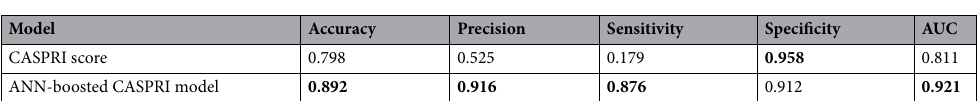
Table 2. Comparison of the performance of CASPRI score and ANN-boosted CASPRI model for predicting functional outcomes of patients received TTM. Univariate logistic regression analysis was performed using the CASPRI score as a continuous variable to calculated the AUC. The higher value among the two models is shown in bold. ANN artificial neural network, AUC area under the receiver operating characteristic curve, CASPRI Cardiac Arrest Survival Postresuscitation In-hospital.